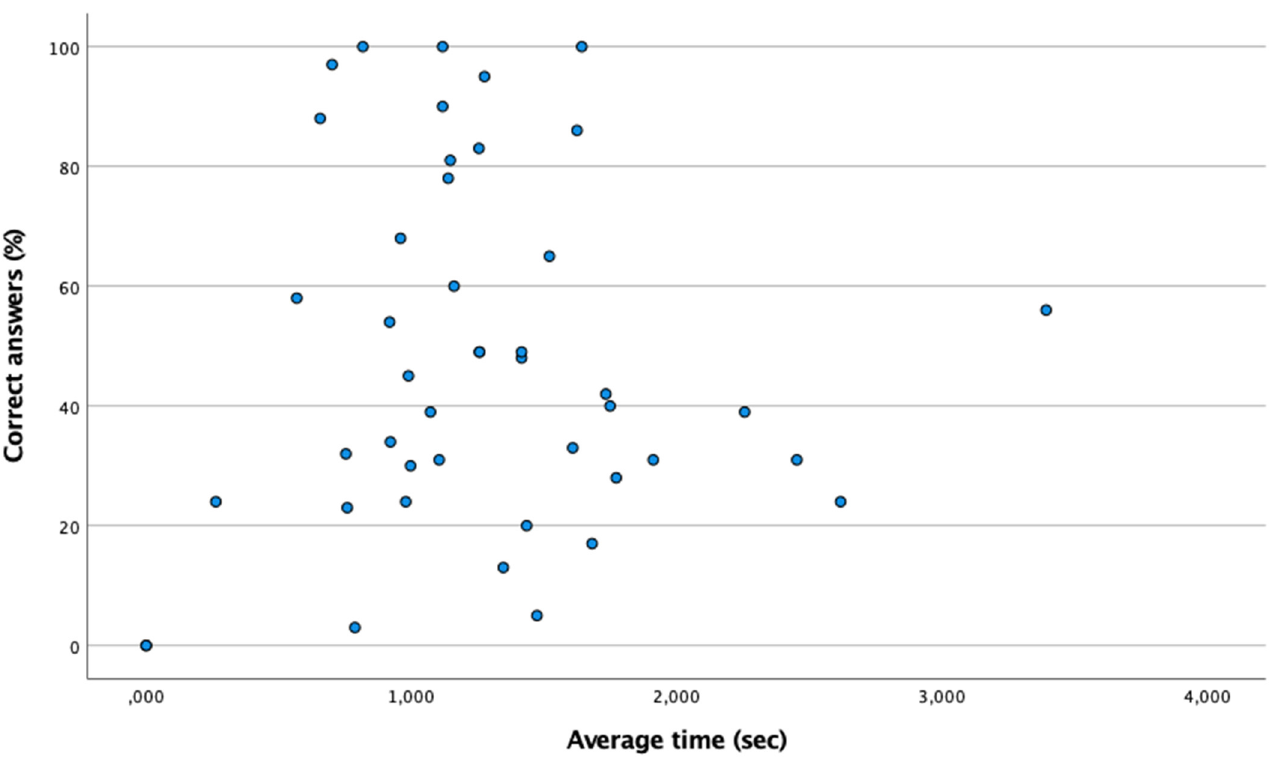
Figure 6. Absence of relationship between the percentage of correct answers and the mean time in the reaction capacity. The point (0,0) means that there is no correct answer.